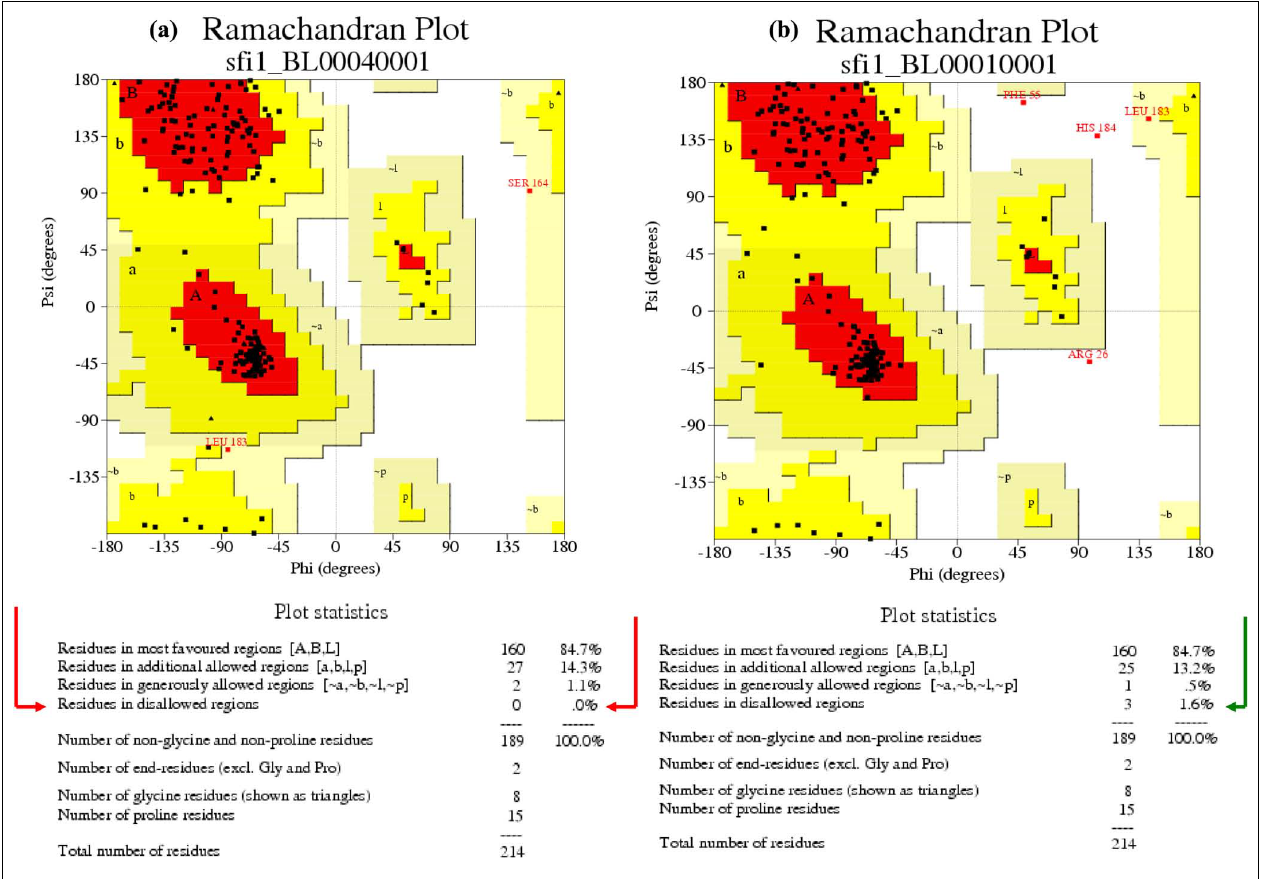
FIGURE 1 | The Ramachandran plot of sfi1_BL00040001 (A) , and sfi1_BL00010001 (B)